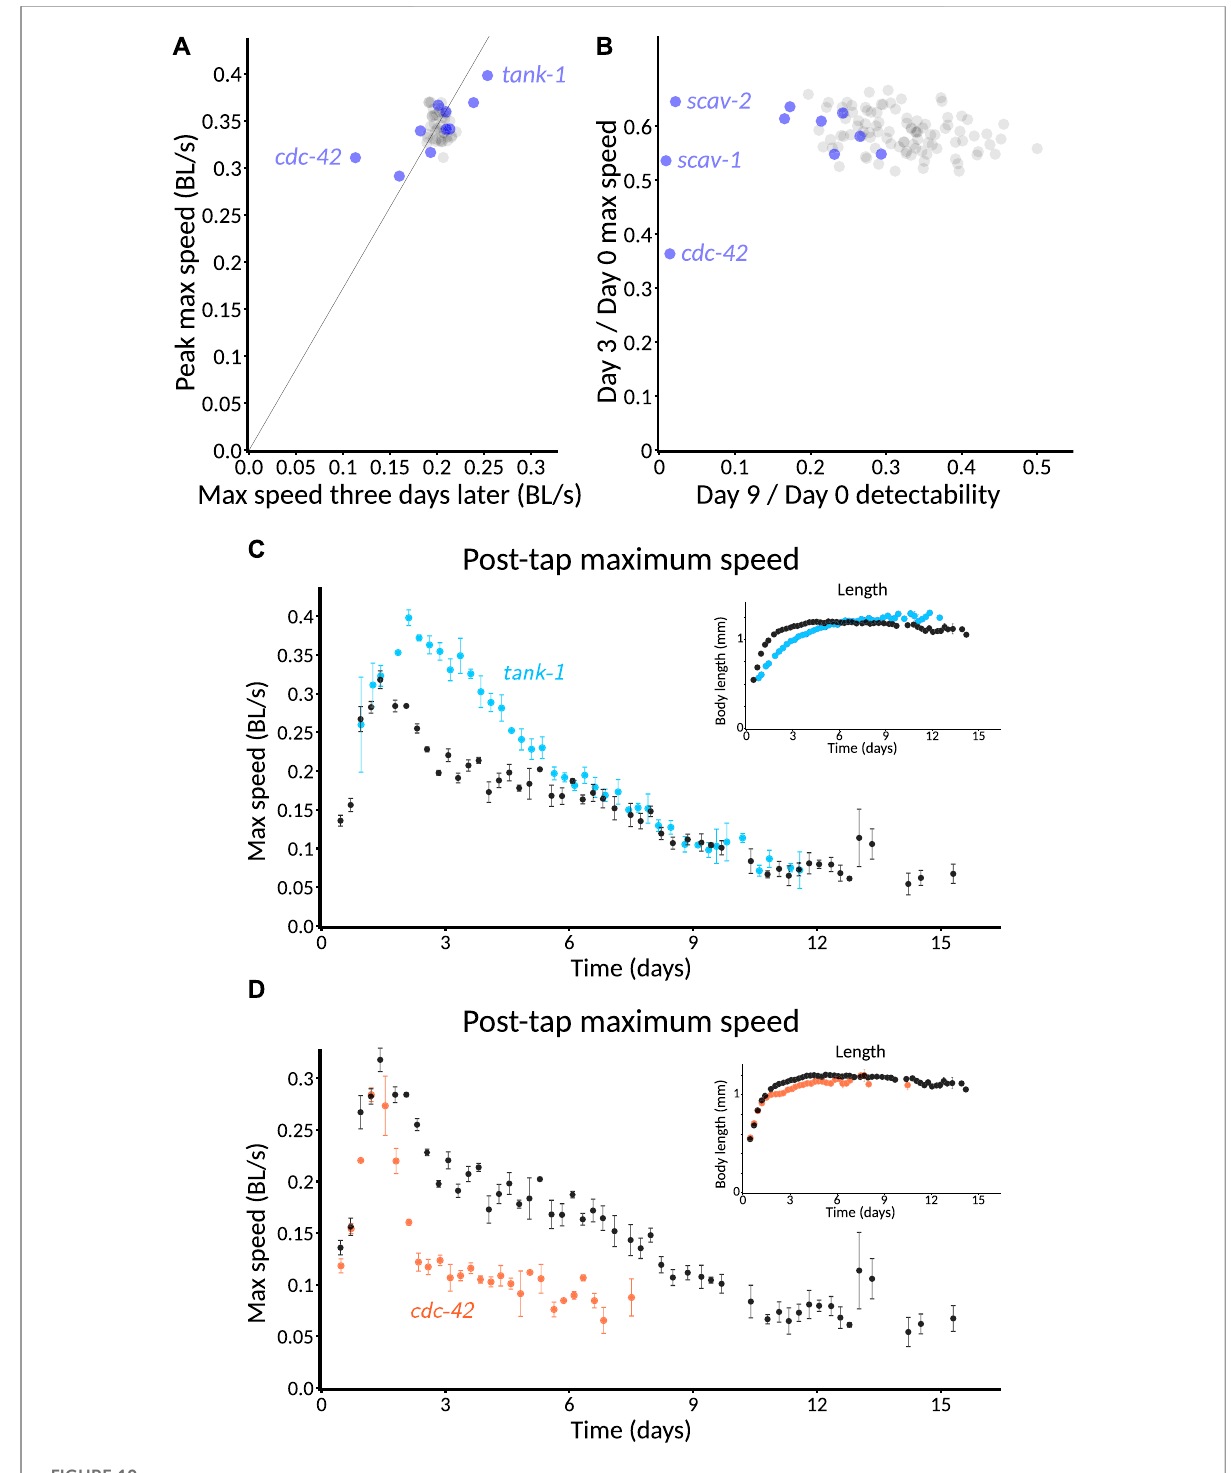
FIGURE 10 Pilotscreenofgenecandidatesimplicatedinhealthymammalianaging. (A) Effectonearlyvigor.Arousedmaximumspeedatpeak vs .threedays laterforRNAioftencandidategeneswith3 – 4platesperconditionand30 – 60wormsperplate(blue)comparedtorandom3 – 4platesamplesoutof the 16 control plates representing the expected distribution (gray). The thin line indicates a constant peak to 3-day speed ratio. The slowest and fastest 3-day conditions are named (slow: cdc-42 , fast: tank-1 ; p < 0.01 that each is from the control distribution), corresponding to the best candidatesforreducedandextendedvigor,respectively.RNAibeganatL1. (B) Effectondetectablemotility.Ratioofanimalsdetectedondaynine vs . day zero (horizontal axis) against theratio of early vigor (day three/day zero speed), with samples from (A) . The three genes showing dramatic loss of